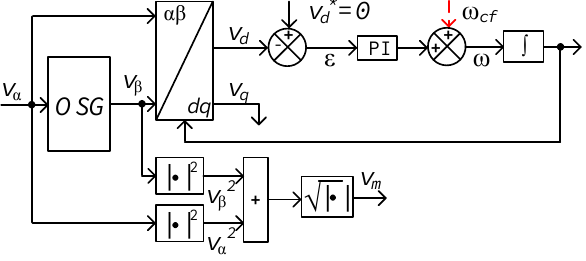
Figure 1. Conventional single-phase Phase-Locked Loop (PLL) with Orthogonal Signal Generation.